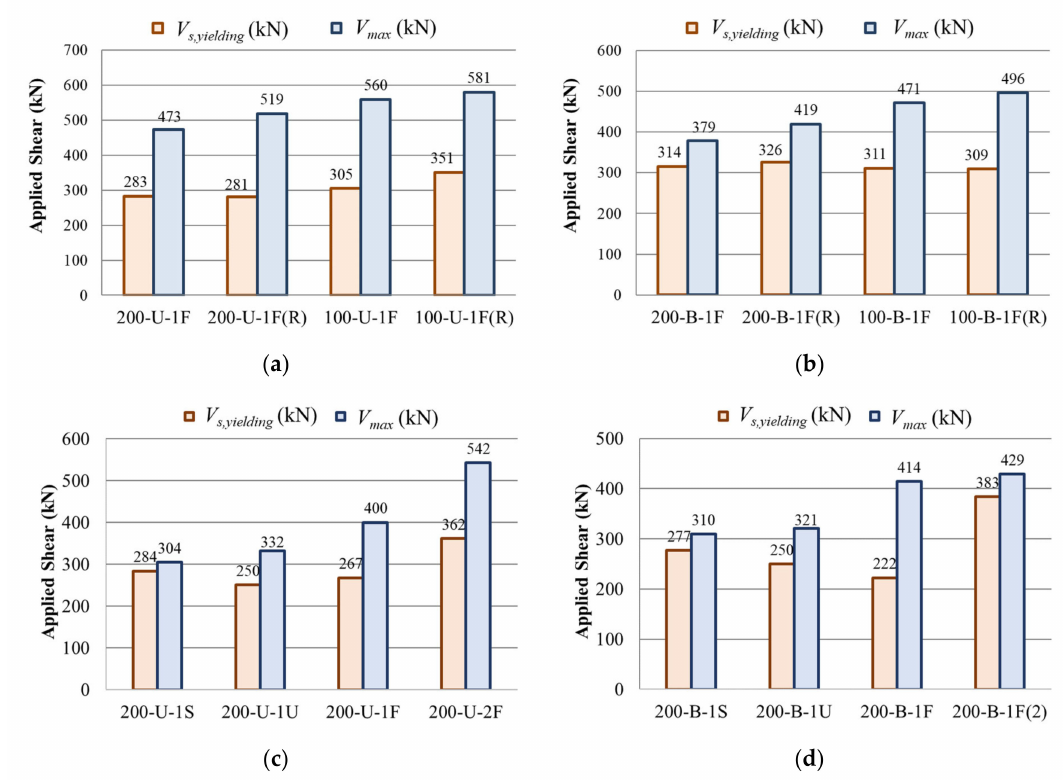
Figure 7. Measured shear force corresponding to stirrup yielding and maximum shear: ( a ) first series: uni-directional layout; ( b ) first series: bi-directional layout; ( c ) second series: uni-directional layout; ( d ) second series: bi-directional